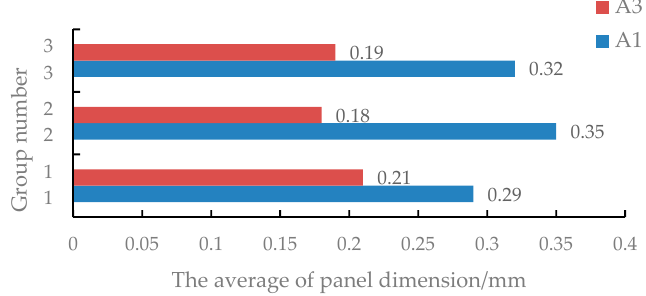
Figure 4 . Effect of veneer species on panel dimension.